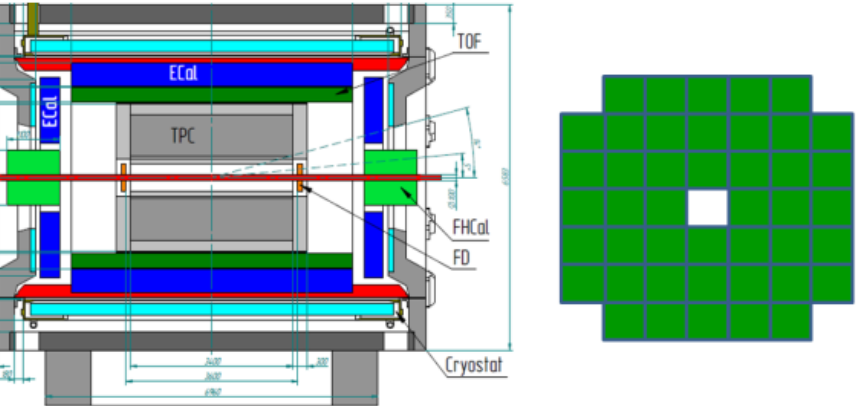
Figure 1. Left: the side view of the MPD setup. Right: schematic view of FHCal transverse segmenta- Figure 1. Left — the side view of the MPD setup. Right — schematic view of FHCal transverse segmentation.